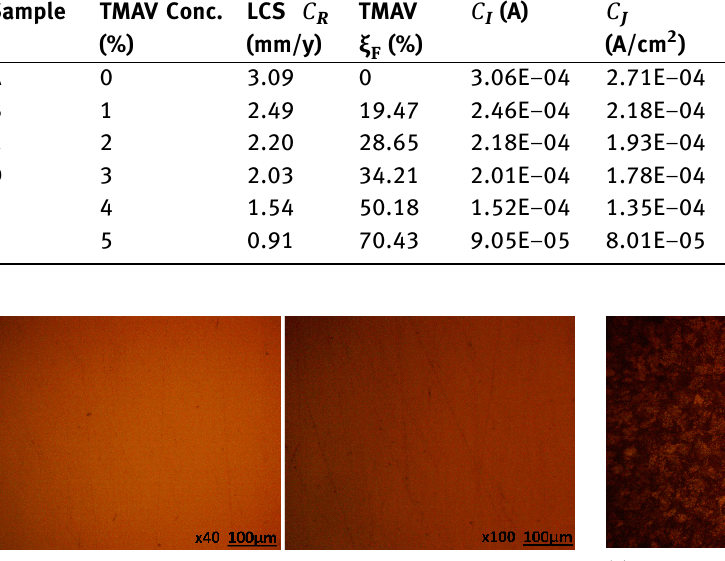
Figure 2: Optical image of LCS surface before polarization